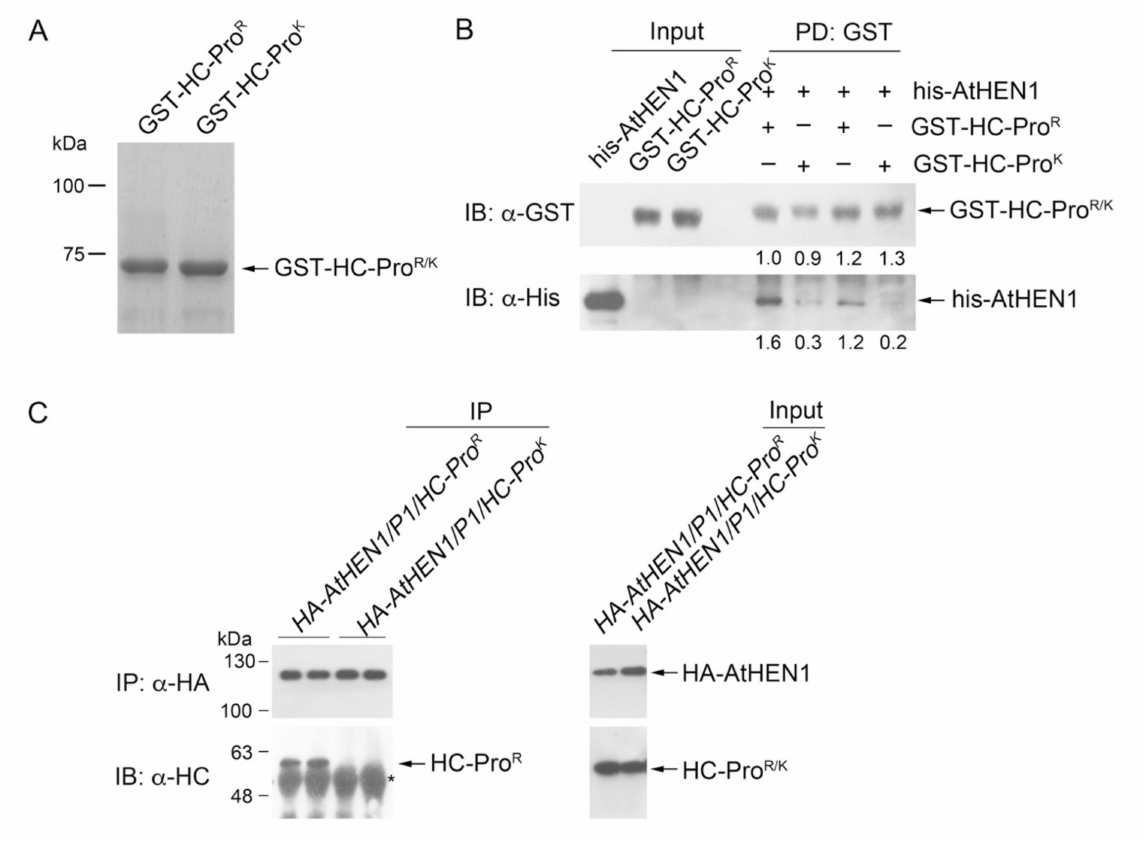
Figure 4. In vitro and in vivo HC-Pro R and HEN1 interaction. ( A ) The SDS-PAGE for GST-HC-Pro R/K and the band at around 75 kDa shows the expected protein size. ( B ) In vitro pull-down assay for the evaluation of the GST-HC-Pro R , GST-HC-Pro K , and his-HEN1 interaction. ( C ) In vivo co-IP assay to examine the binding activity between GST-HC-Pro R or GST-HC-Pro K , and HA-HEN1. * Heavy chain of